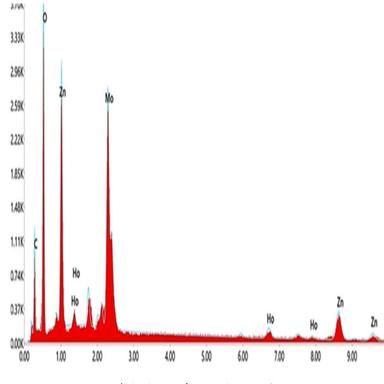
EDS spectrum of MTZ - ZnMoO4 nanocomposite.